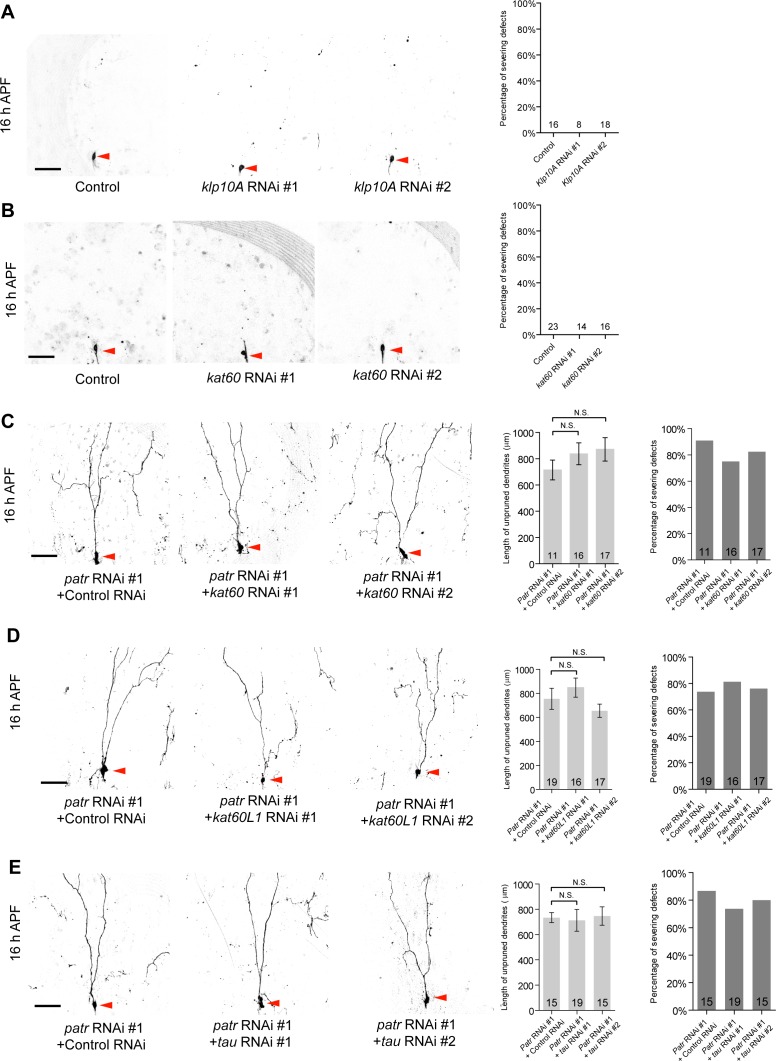
patronin appears not to genetically interact with kat-60, kat-60L1 or tau in dendrite pruning.(A–E) Live confocal images of ddaC neurons expressing mCD8-GFP driven by ppk-Gal4 at 16 hr APF. Similar to the control neurons, klp10A RNAi (#1 or #2) or kat-60 RNAi (#1 or #2) ddaC neurons pruned away their larval dendrites by 16 hr APF (A–B). The pruning defects in patronin RNAi #1 ddaC neurons were not suppressed or enhanced by knockdown of kat-60 (RNAi #1 or #2) (C), kat-60L1 (RNAi #1 or #2) (D) or tau (RNAi #1 or #2) (E). Red arrowheads point to the ddaC somas. Bar charts on the right depict quantification of total length of unpruned ddaC dendrites and/or the severing defects at 16 hr APF. Scale bars represent 50 μm. Error bars represent SEM. The number of samples (n) in each group is shown on the bars. N.S., not significant, as assessed by one-way ANOVA test.10.7554/eLife.39964.027Figure 7—figure supplement 1—source data 1.Extended statistical data as Microsoft Excel spreadsheet.